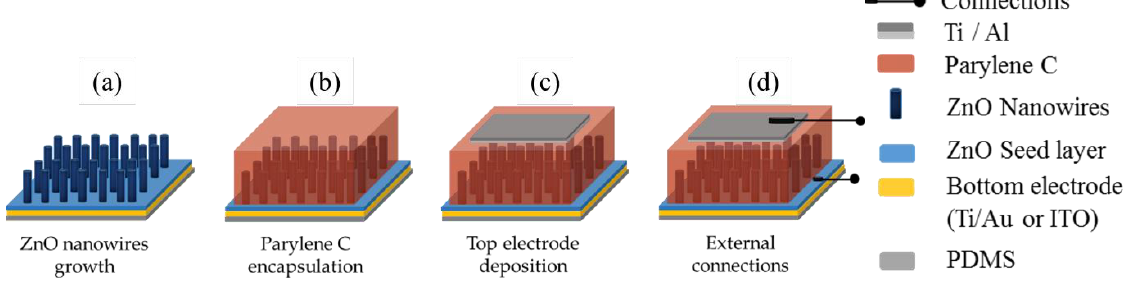
Figure 2. Fabrication steps of flexible PENG: ( a ) hydrothermal growth of ZnO NWs, ( b ) parylene-C deposition, ( c ) top electrode deposition, and ( d ) wires connection.